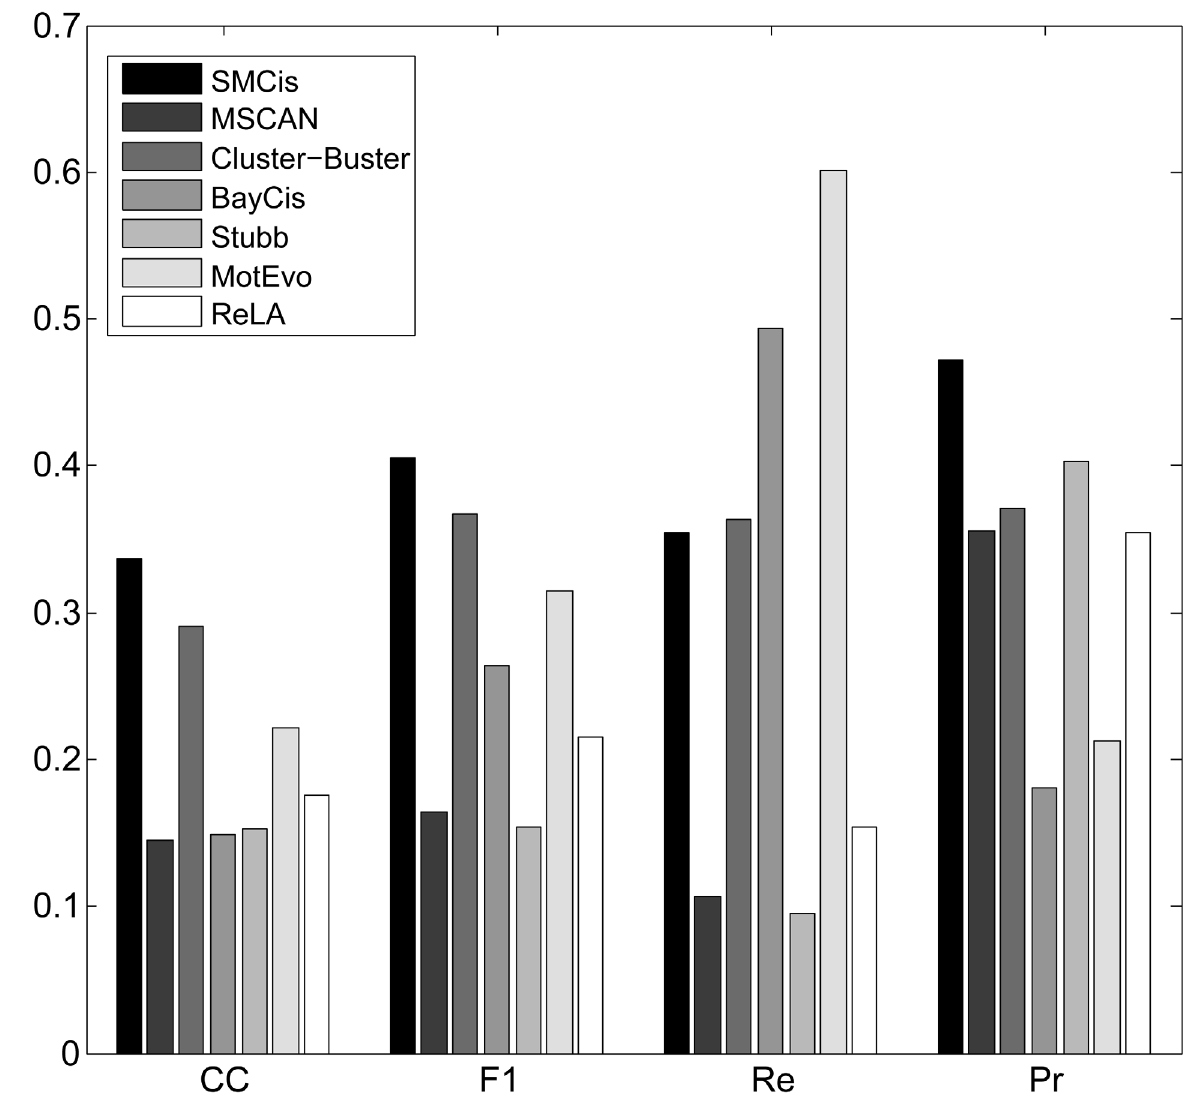
Fig 6. Performance of all methods on the whole Drosophila early development